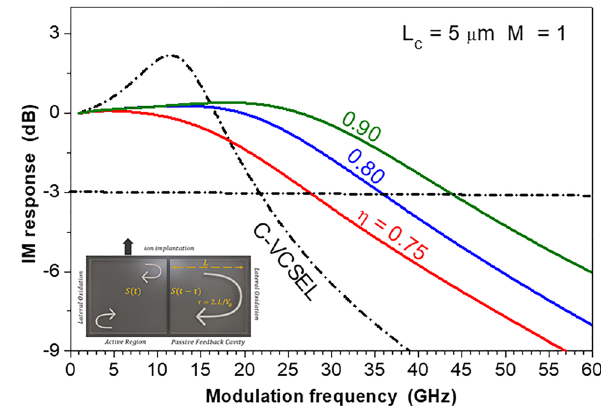
Figure4: IMresponsewithbandwidthimprovementofthedesignof TCC VCSEL with L C = 5 μ m when η = 0.75, 0.8, and 0.9. The IM response of the C-VCSEL is plotted for comparison with the dashed- dotted line. Figure 4. These spectra correspond to TCC length of = 5 μ m and coupling ratio of η = 0.75, 0.8, and 0.9. The L C fi gure indicates an increase of MBW beyond that of the conventional VCSEL (C-VCSEL), f = 21.5 GHz, to 3dB0 = 27.5, 36, and 40 GHz when η = 0.75, 0.8, and 0.9, f 3dB respectively. This range of η corresponds to very strong transverse optical feedback. The increase of MBW can be attributed to the strong anti-phase coupling between the transverse coupled radiation and the vertically lasing ra- diation in the VCSEL cavity [20]. The predicted values of MBW f are plotted as a 3dB function of the coupling ratio η in Figure 5 for TCC lengths of L = 5 and 6 μ m. The fi gure indicates the increase of f 3dB C in the regime of very strong feedback with coupling ratios of η > 0.71 when L = 5 μ m and η > 0.78 when L = 6 μ m. The C C